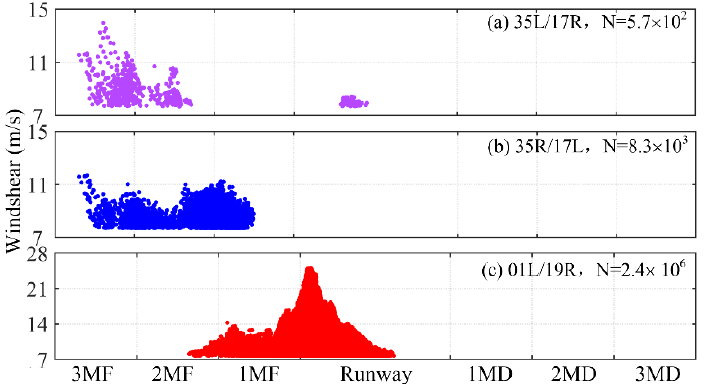
Figure 5. Windshear center distribution on the runway due to the microburst, on 28 April, 15:54:12– 15:54:42 (UTC). ( a ) 35L/17R, ( b ) 35R/17L, ( c ) 01L/19R. N is the number of windshear ramps that exceed 7 m/s. 3MF, 2MF, and 1MF in the X axis mean the three monitor subareas in the landing sides, while 3MD, 2MD, and 1MD mean the monitor subareas in the departure sides.